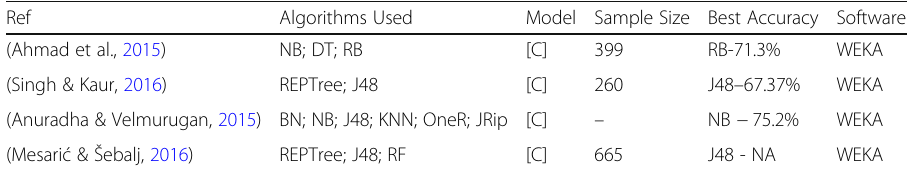
Table 3 Summary of results of research seeking year level